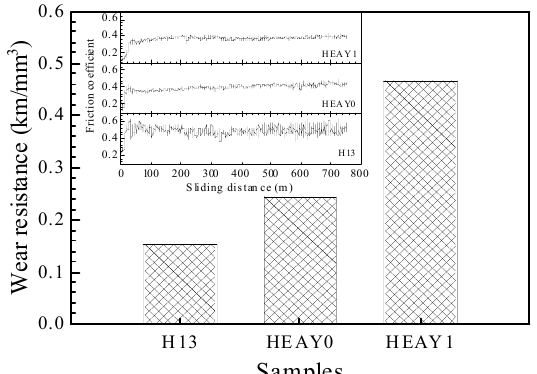
Figure 5. Weight loss and coefficient of friction for H13 substrate and laser cladding coatings without and with Y 2 O 3 addition.